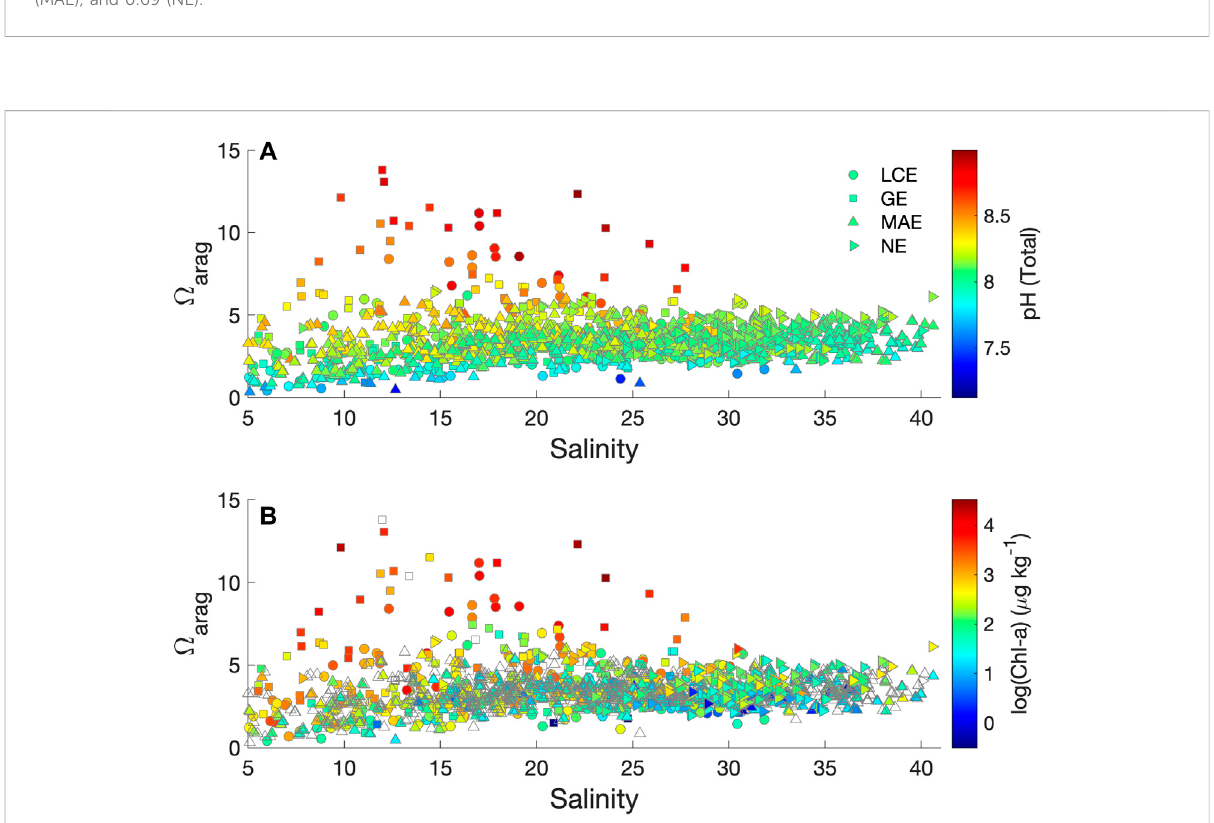
FIGURE 10 Ω arag vs.salinityandpHorchlorophyll-ainthefourstudiednwGOMestuaries.Colorin log scale (B) . Open symbols represent no chlorophyll